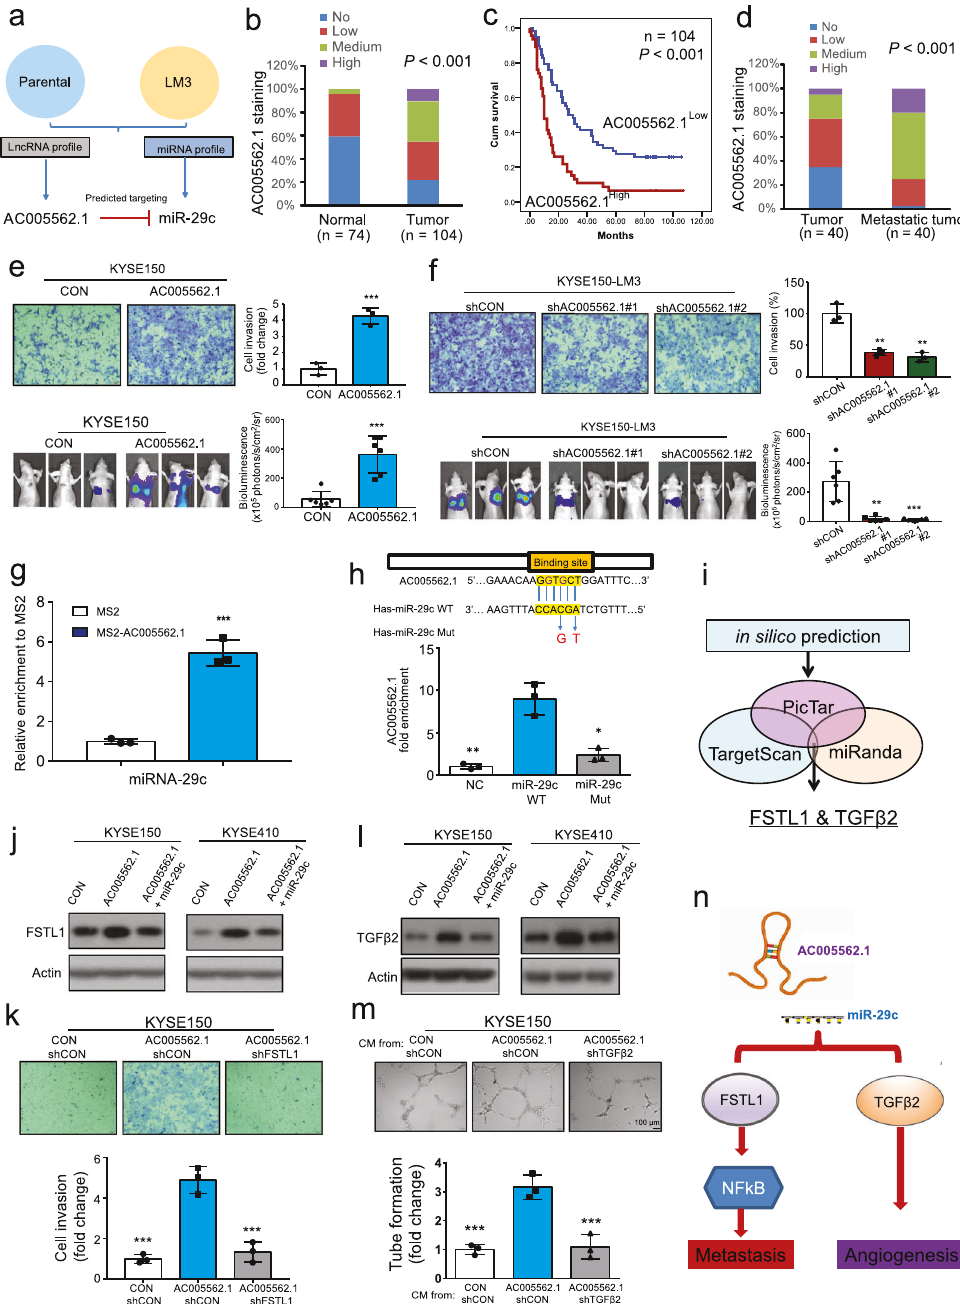
Fig. 1 a Diagram showing the approaches used in the study to identify the AC005526-hsa-miR-29c regulatory pair. b Expression pattern of AC005562.1 and hsa-miR-29c in 74 normal tissues and 104 ESCC tissues. c Kaplan-Meier plots were used to compare the overall survival of 104 patients with ESCC strati fi ed according to AC005562.1 or hsa-miR-29c expression. d Expression pattern of AC005562.1 and hsa-miR-29c in 40 pairs of primary esophageal cancer and matched metastatic tissues. e In vitro and in vivo assay comparing the invasion and metastasis between AC005562.1-overexpressing cells and vector control cells. f The invasion and metastasis of AC005562.1-knockdown cells and the vector control cells were compared. g MS2 RNA immunoprecipitation showing the binding between hsa-miR-29c and AC005562.1. h The wide-type or mutant forms of hsa-miR-29c are shown (upper panel). A pull-down assay showing that AC005562.1 was highly enriched in the sample pulled down by wild-type hsa-miR-29c but not mutant hsa-miR-29c. i Diagram showing the strategy to identify direct targets of hsa- miR-29c. j Western blot showing the expression of FSTL1 when the AC005562.1 and hsa-miR-29c expression was manipulated. k Boyden chamber assay showing the invasion of ESCC cells when the AC005562.1 and FSTL1 expression was manipulated. l Western blot showing the expression of TGF β 2 when the AC005562.1 and hsa-miR-29c expression was manipulated. m Tube formation assay showing that knockdown of TGF β 2 attenuated the promoting effect of AC005562.1 on angiogenesis in vitro. n Summary diagram. Bars, SD; ** P < 0.01